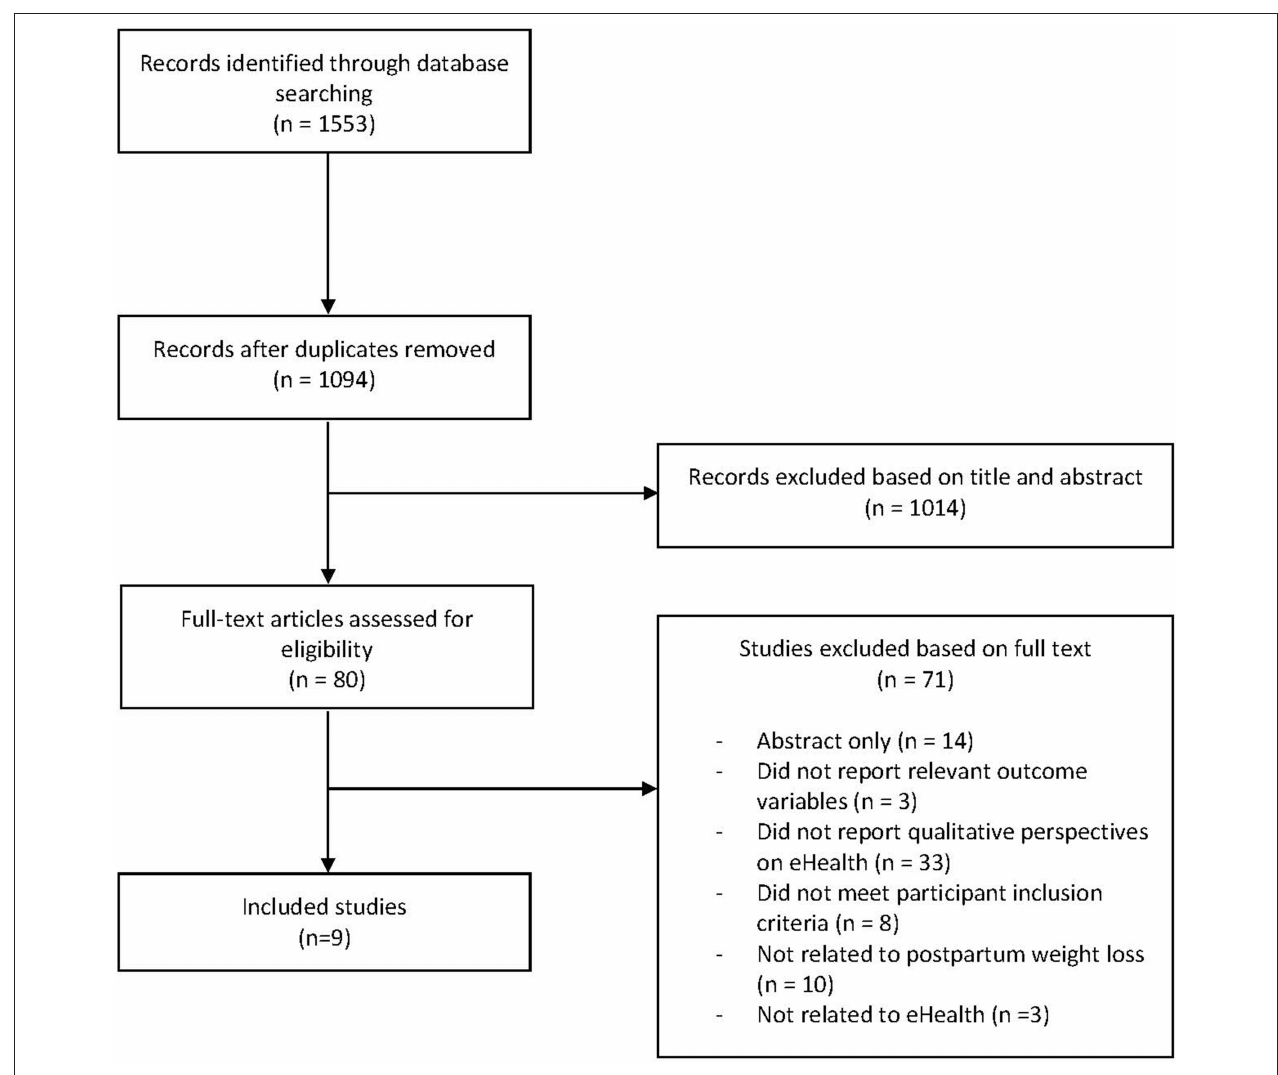
FIGURE 1 | Flow chart of study